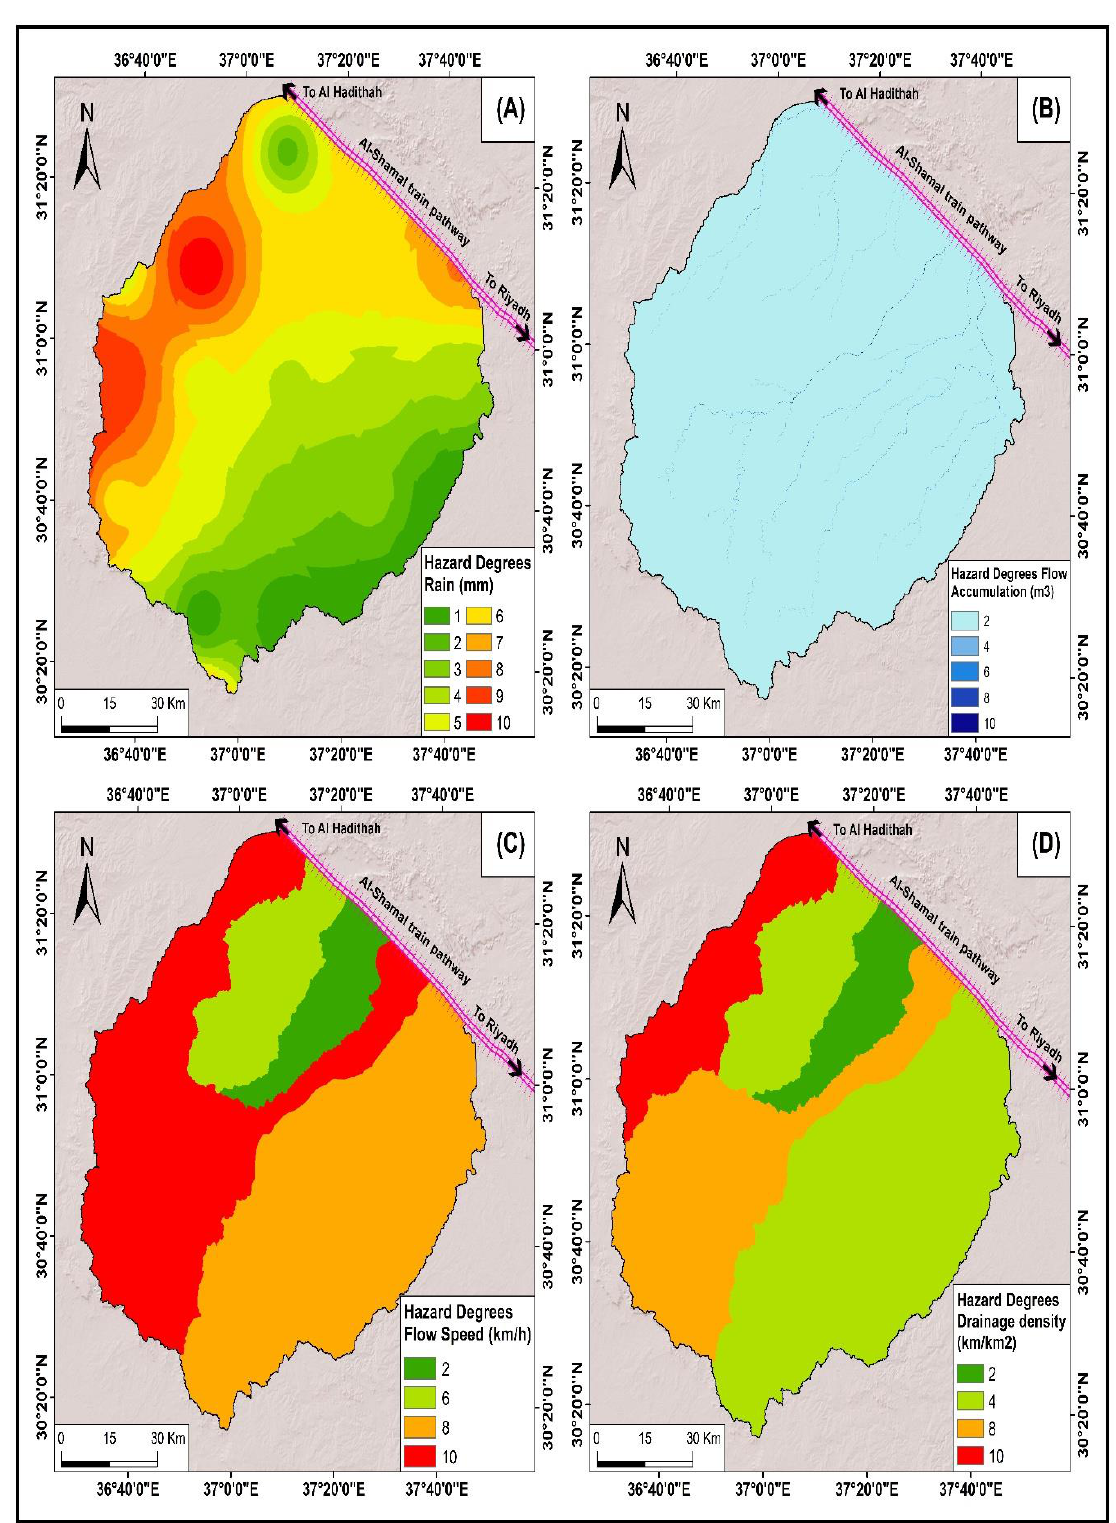
Figure 10. The degrees of floods hazard affecting the Al-Shamal train pathway in Qurayyat city in 2020 in the study: ( A ) rainfall density; ( B ) flow accumulation; ( C ) runoff speed; ( D ) drainage density.